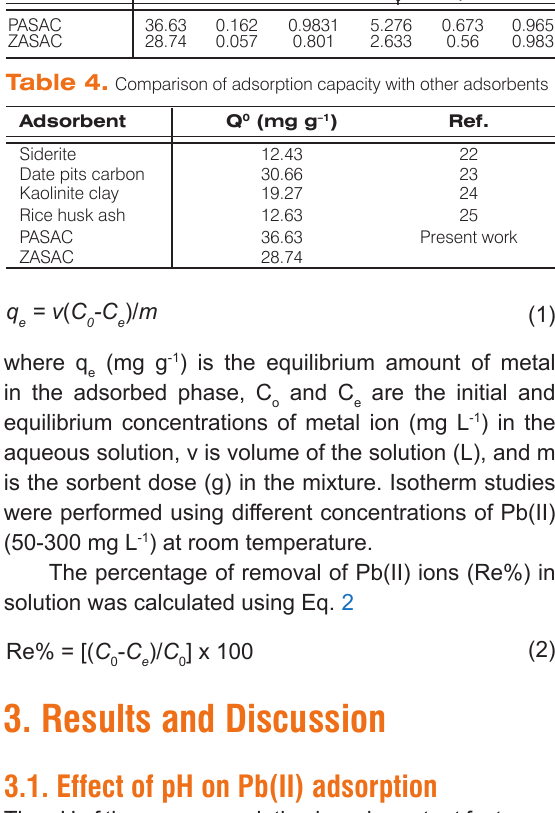
Table 3. Freundlich and Langmuir isotherm constants for the lead adsorption on the PASAC and ZASAC adsorbent Adsorbent